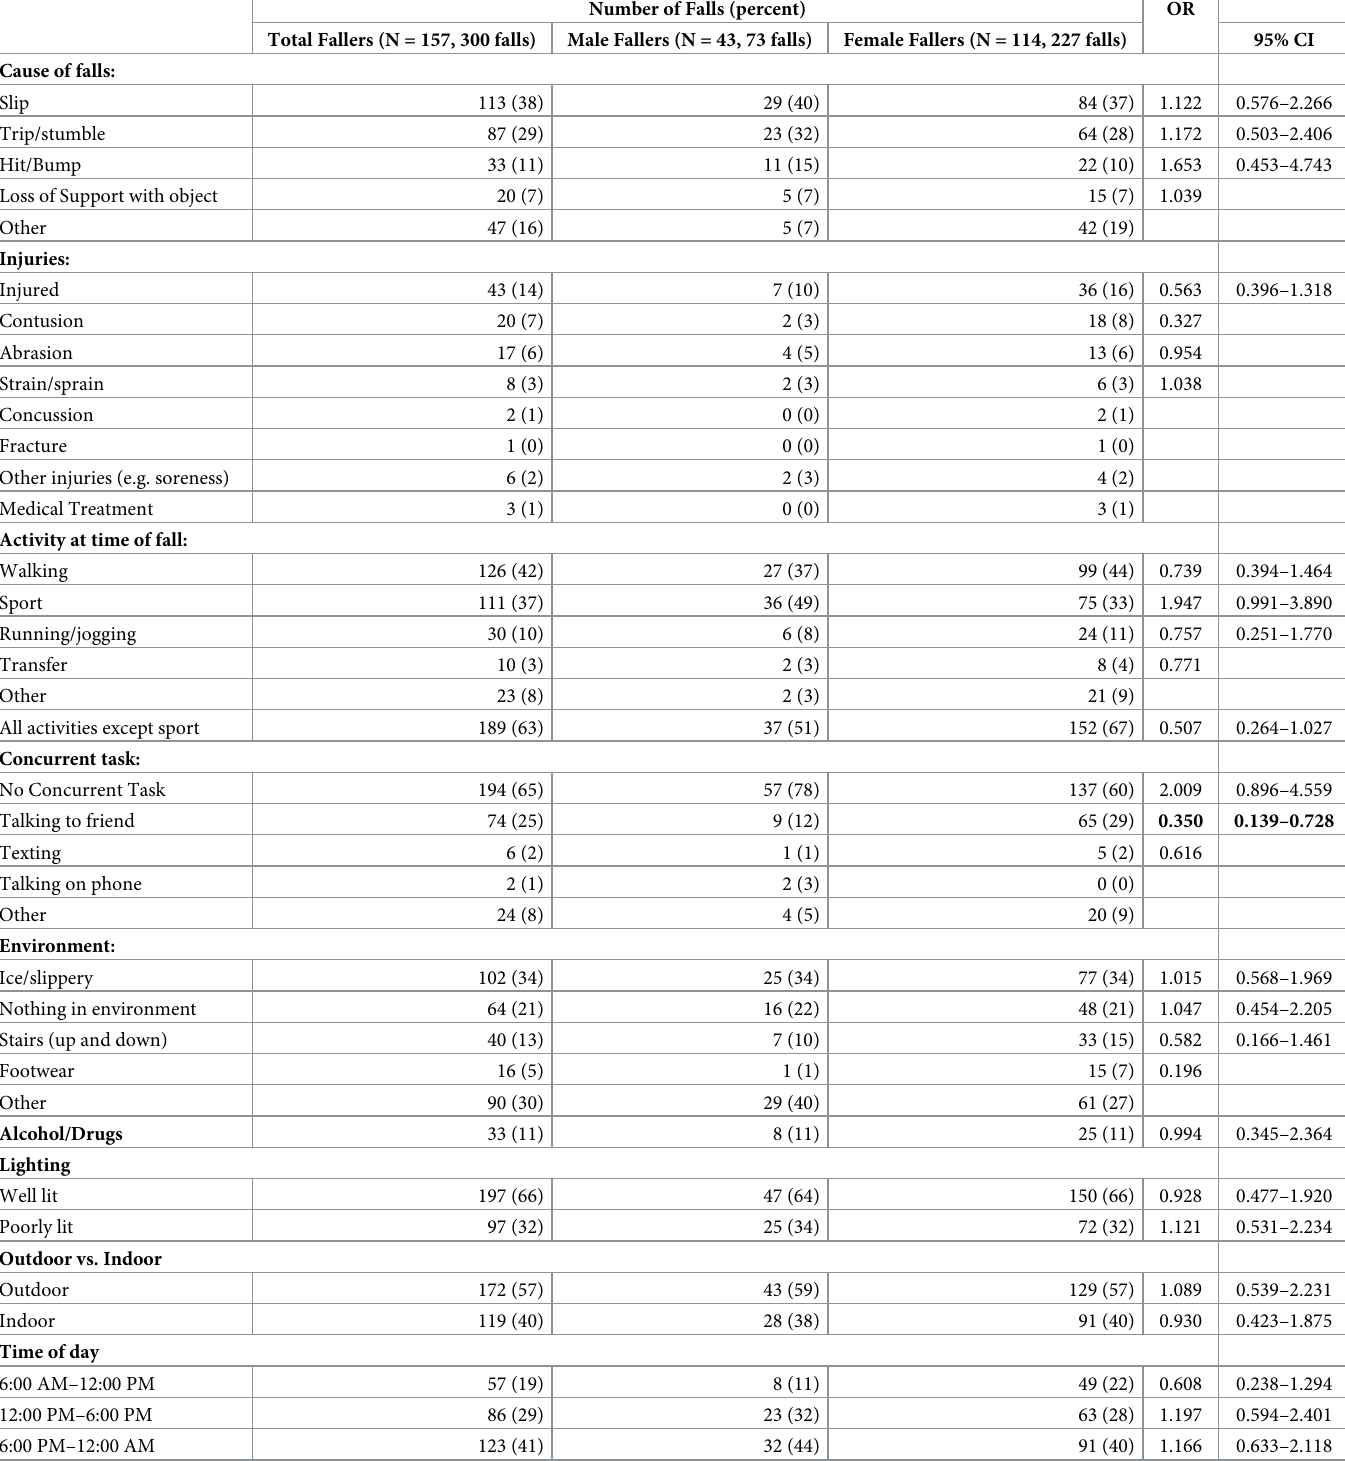
Table 2. Fall circumstances for all fallers, and comparison for male versus female